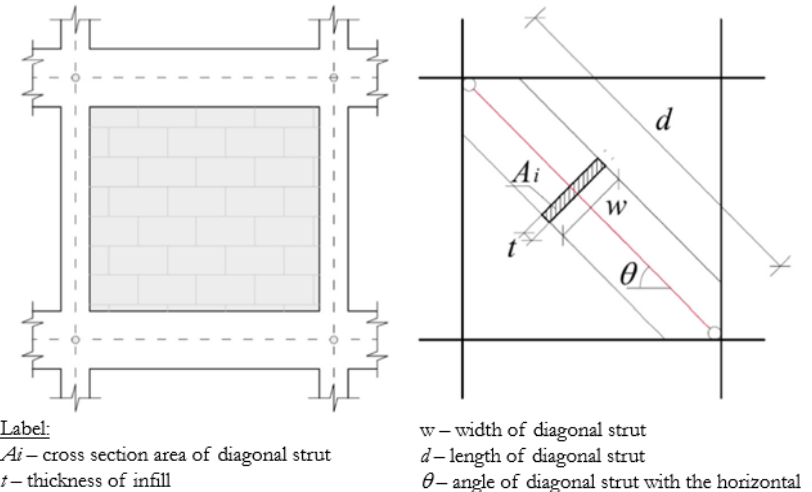
Figure 1. Definition of the diagonal strut and its geometric characteristics. Source: Adapted from Asteris et al.